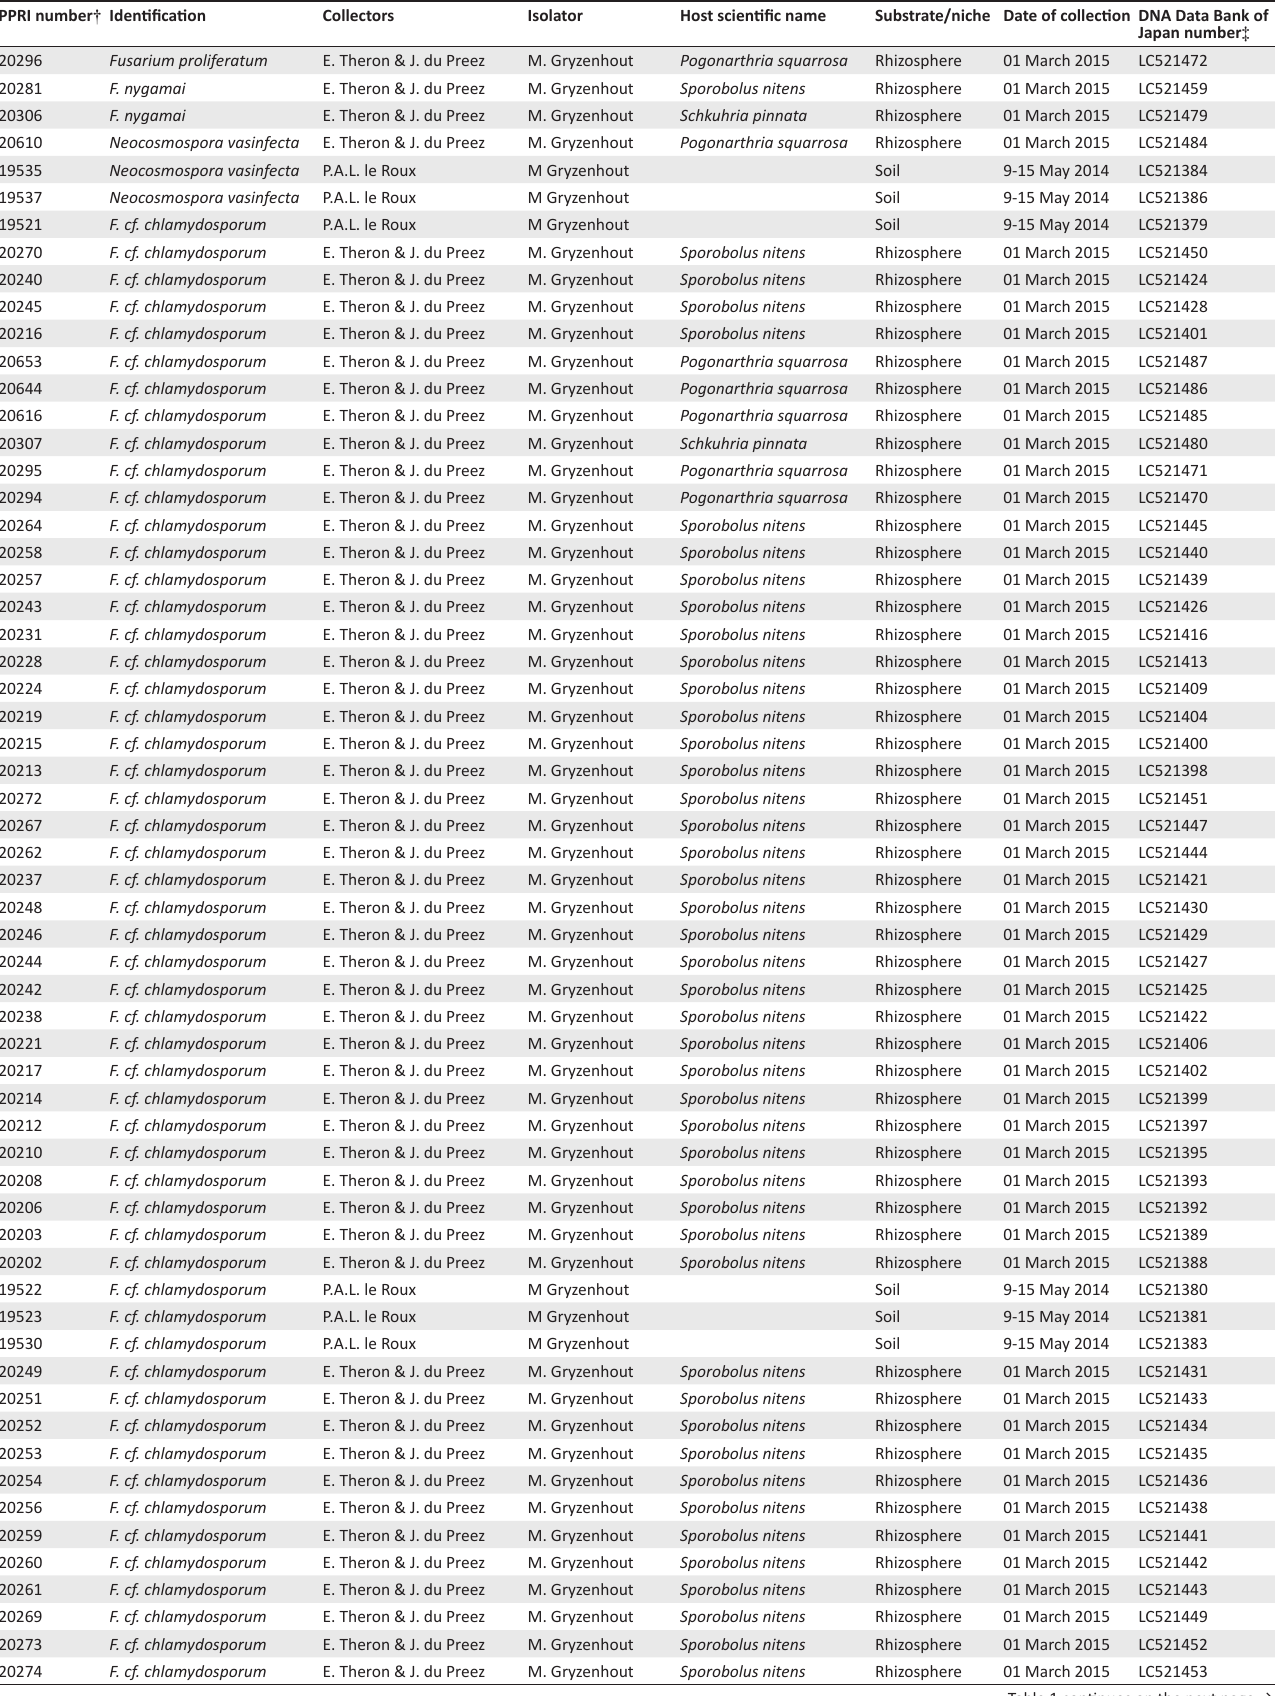
TABLE 1: List of Fusarium isolates identified in this study that originated from the Stevenson-Hamilton catena in Kruger National Park, South